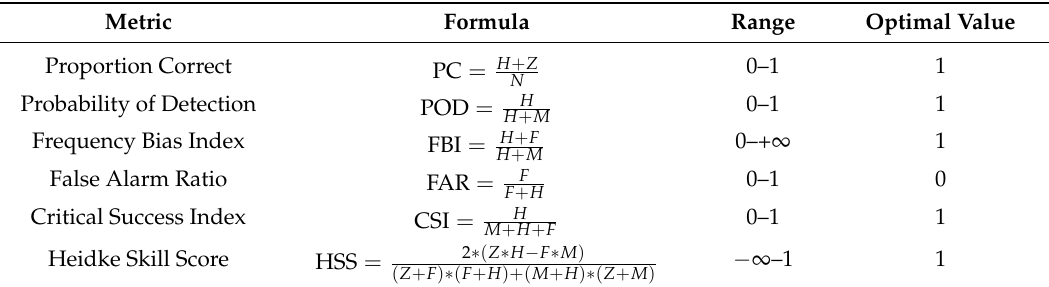
Table 3. Statistical measures for validation of precipitation detection